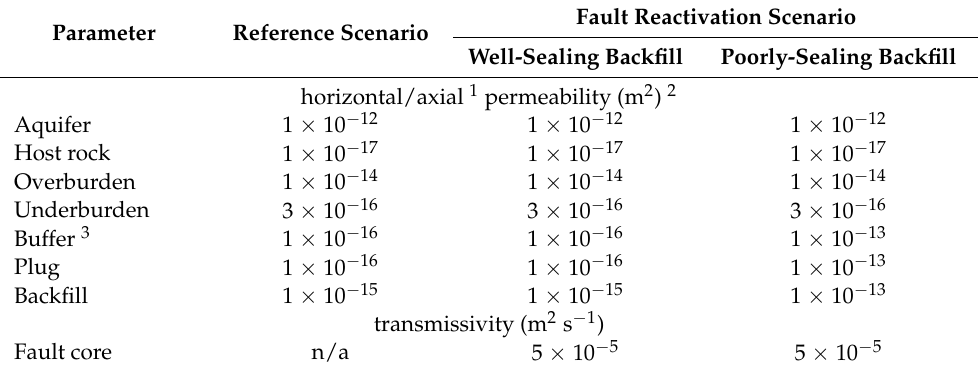
Table 1. Permeabilities defining the differences between reference and disruptive